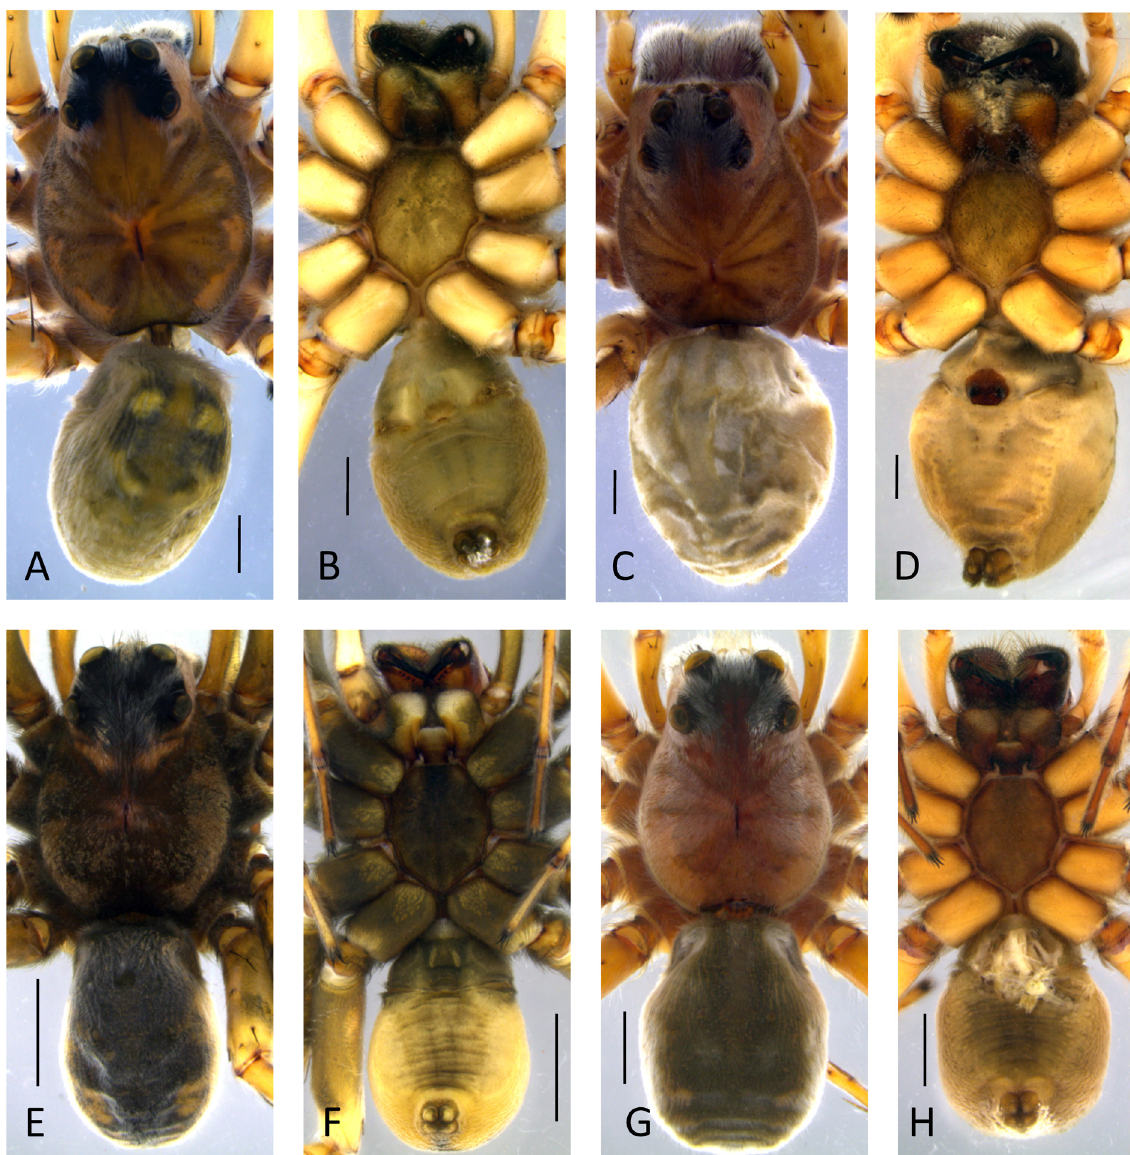
Fig. 14. Tetralycosa Roewer, 1960, microscopic photographs showing dorsal and ventral